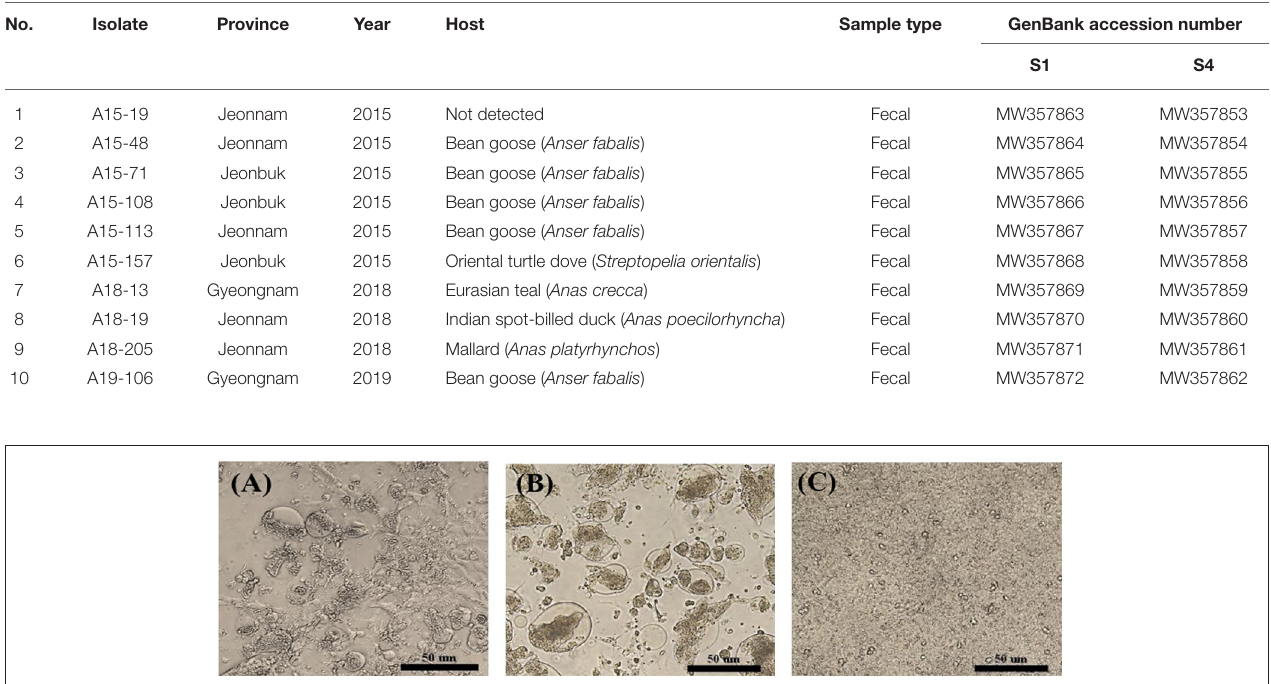
TABLE 2 | ARV obtained in the study, origin of sample, year of isolation, host species, sample type, and GenBank accession number. No.